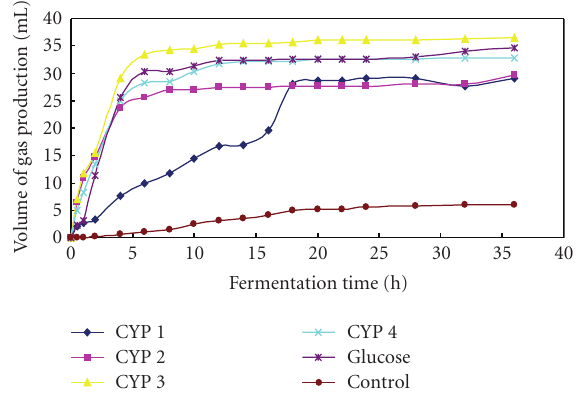
Figure 1: Time-course of gas production by intestinal microbes in response to in vitro supplementation with Chinese Yam polysaccha- ride (CYP) or glucose ( n = 4).